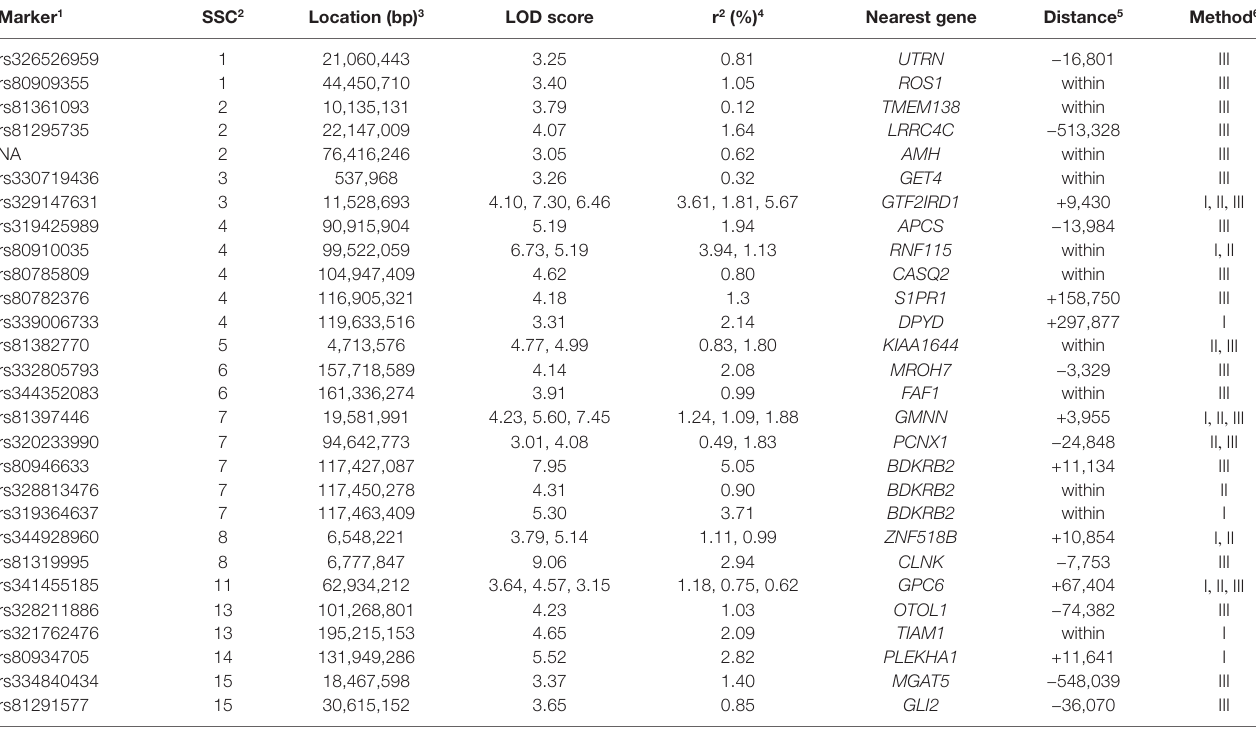
TABLE 4 | Description of significant SNPs identified by multi-locus methods as associated with IMF. Marker 1 SSC